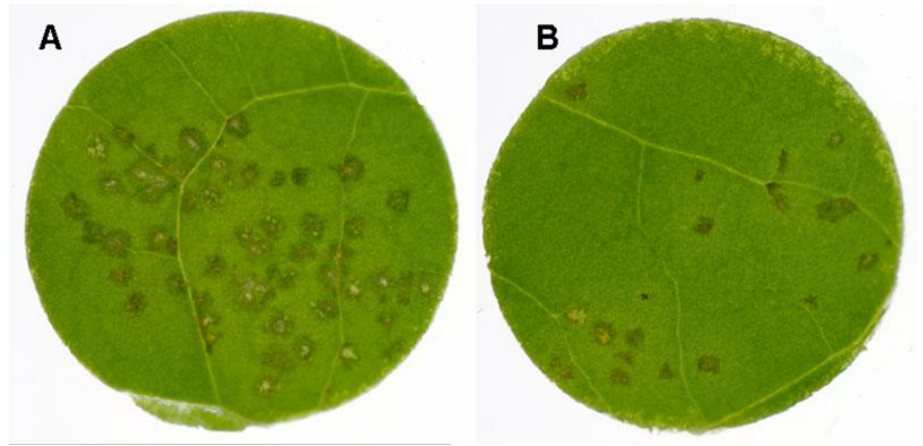
FIGURE 10. Hypersensitive lesions (necrotic spots) in tobacco leaf disks inoculated with TMV and treated with either pure water as a control (A) or As 45x (B); homeopathic treatment (B) induces fewer and smaller lesions with respect to control